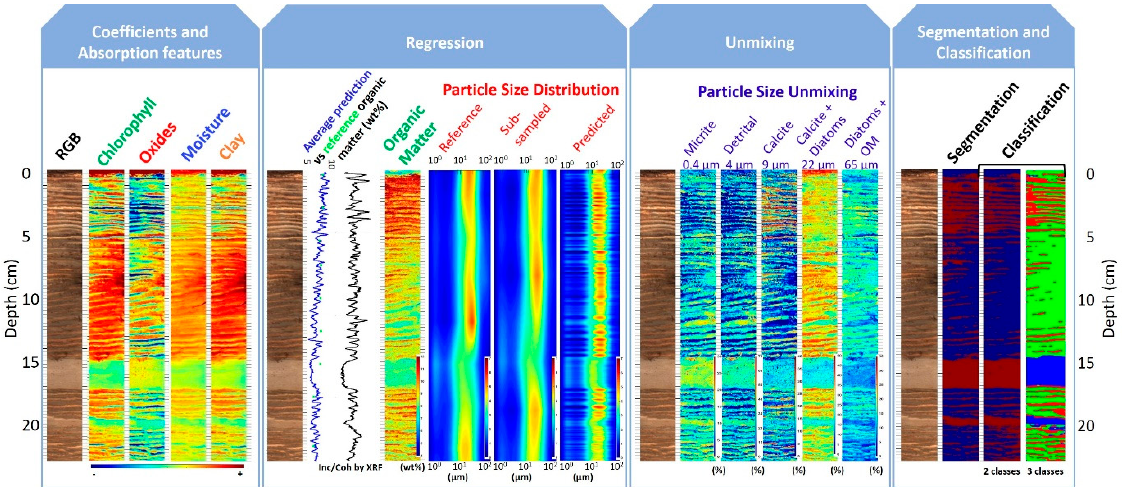
Figure 13. Information extracted from the hyperspectral image of a core from Bourget Lake (France) using different approaches: coefficients and absorption features to obtain semiquantitative pigment and mineral contents; regressions to model proxies with absolute concentrations; unmixing to estimate compound signatures and relative contents; segmentations and classifications to characterize deposits (image adapted from [49]).